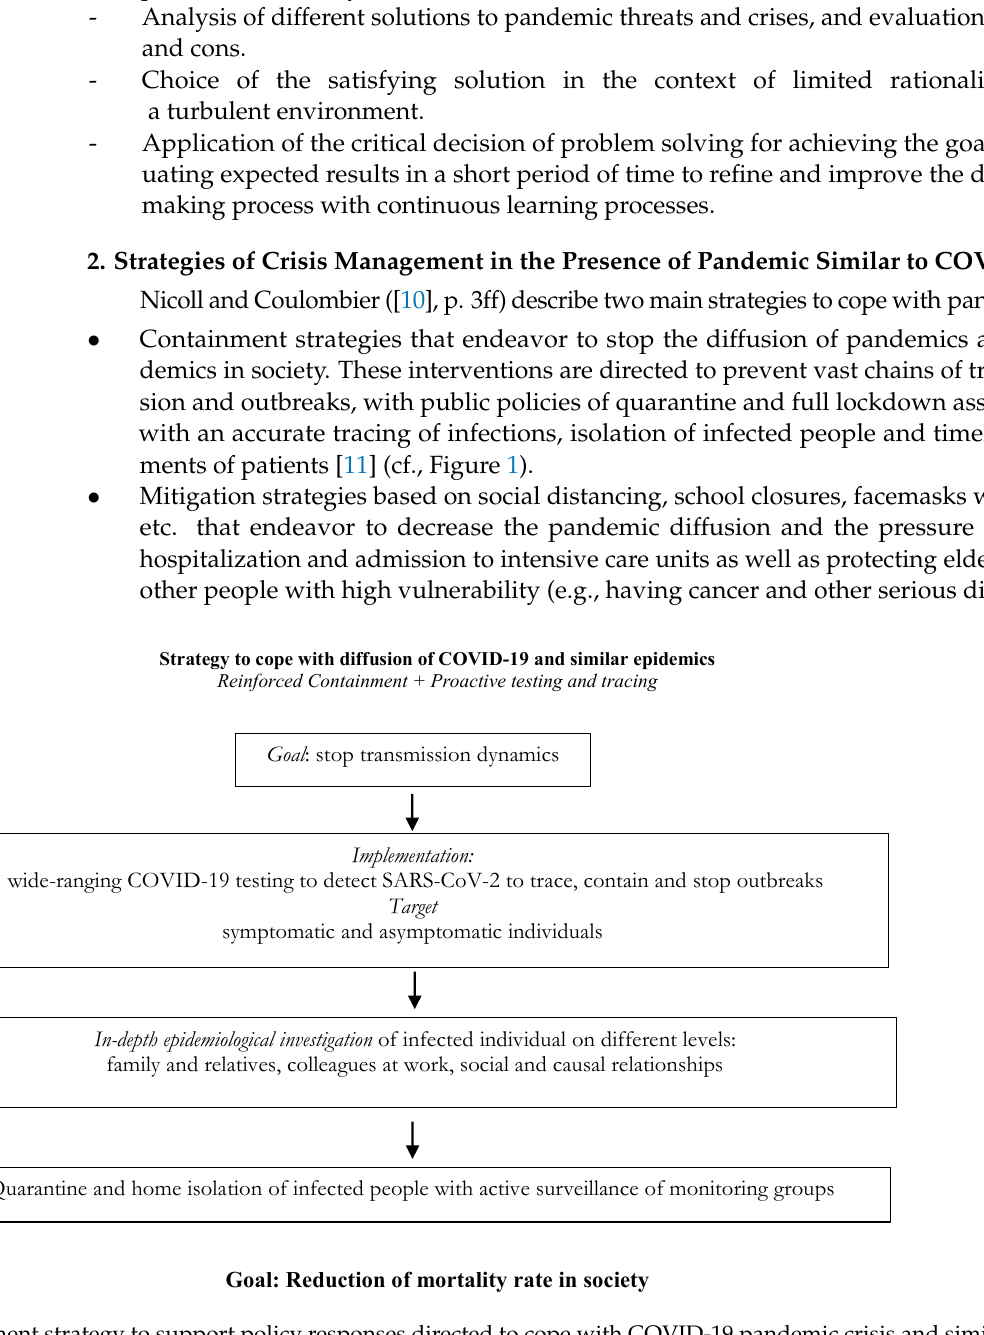
Figure 1. Containment strategy to support policy responses directed to cope with COVID-19 pandemic crisis and similar epidemics in future. Source: author’s own figure.